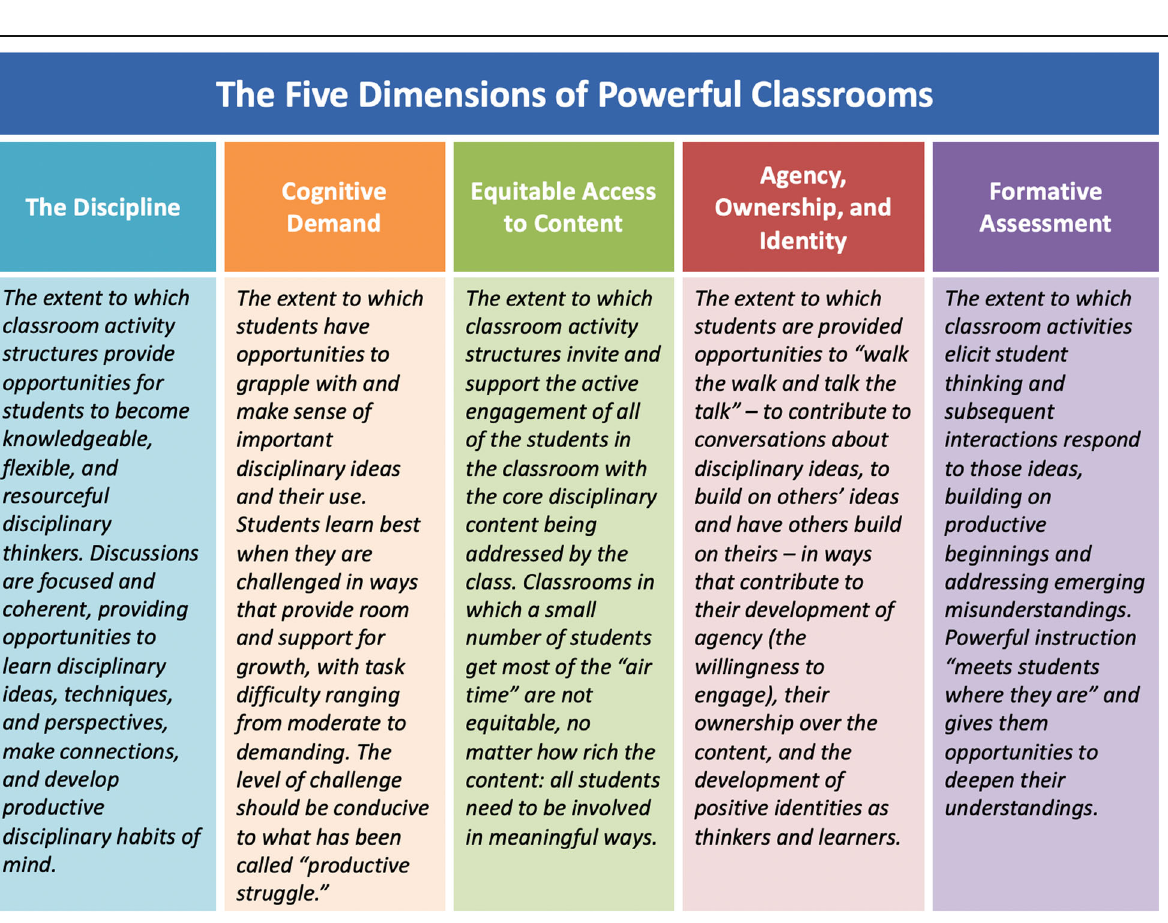
Fig. 2 The domain-general version of the TRU